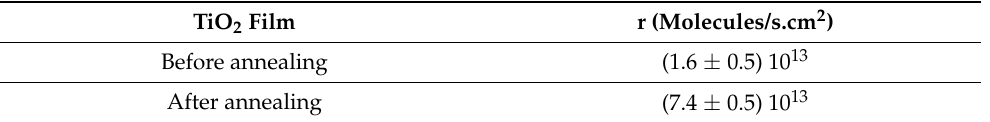
Table 1. Disappearance rate of formic acid obtained in the presence of an unstructured TiO 2 film before and after annealing at 500 ◦ C.